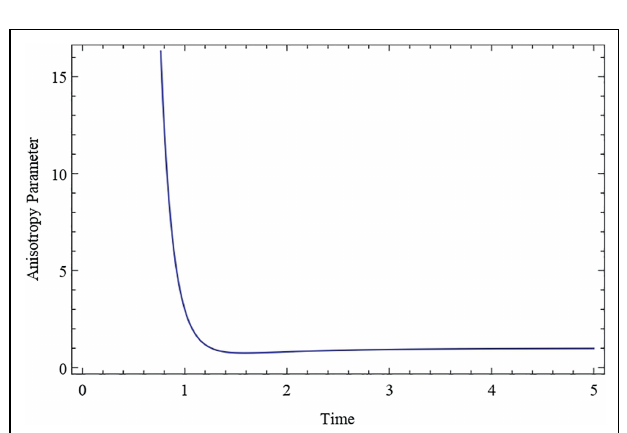
FIGURE 8 | Shear Stress σ 2 vs. time.